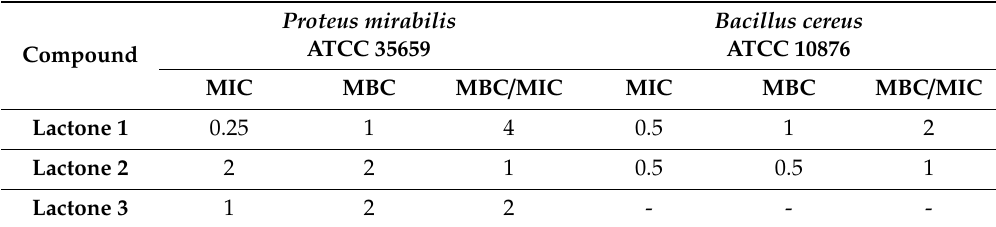
Table 1. Minimum Inhibitory Concentration (MIC) and Minimum Bactericidal Concentration (MBC) of lactones 1 – 3 (mg /